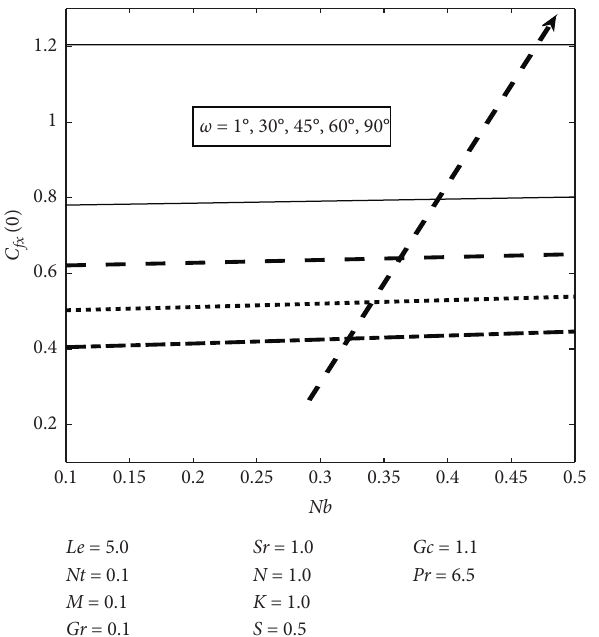
Figure 21: Variations skin friction with Nb for different values of ω